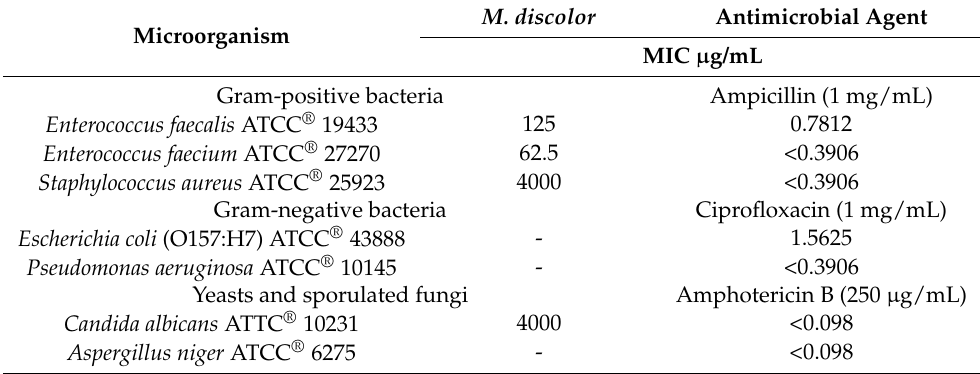
Table 3. Minimum inhibitory concentration calculated for the Myrcianthes discolor essential oil against seven human pathogenic microorganisms.